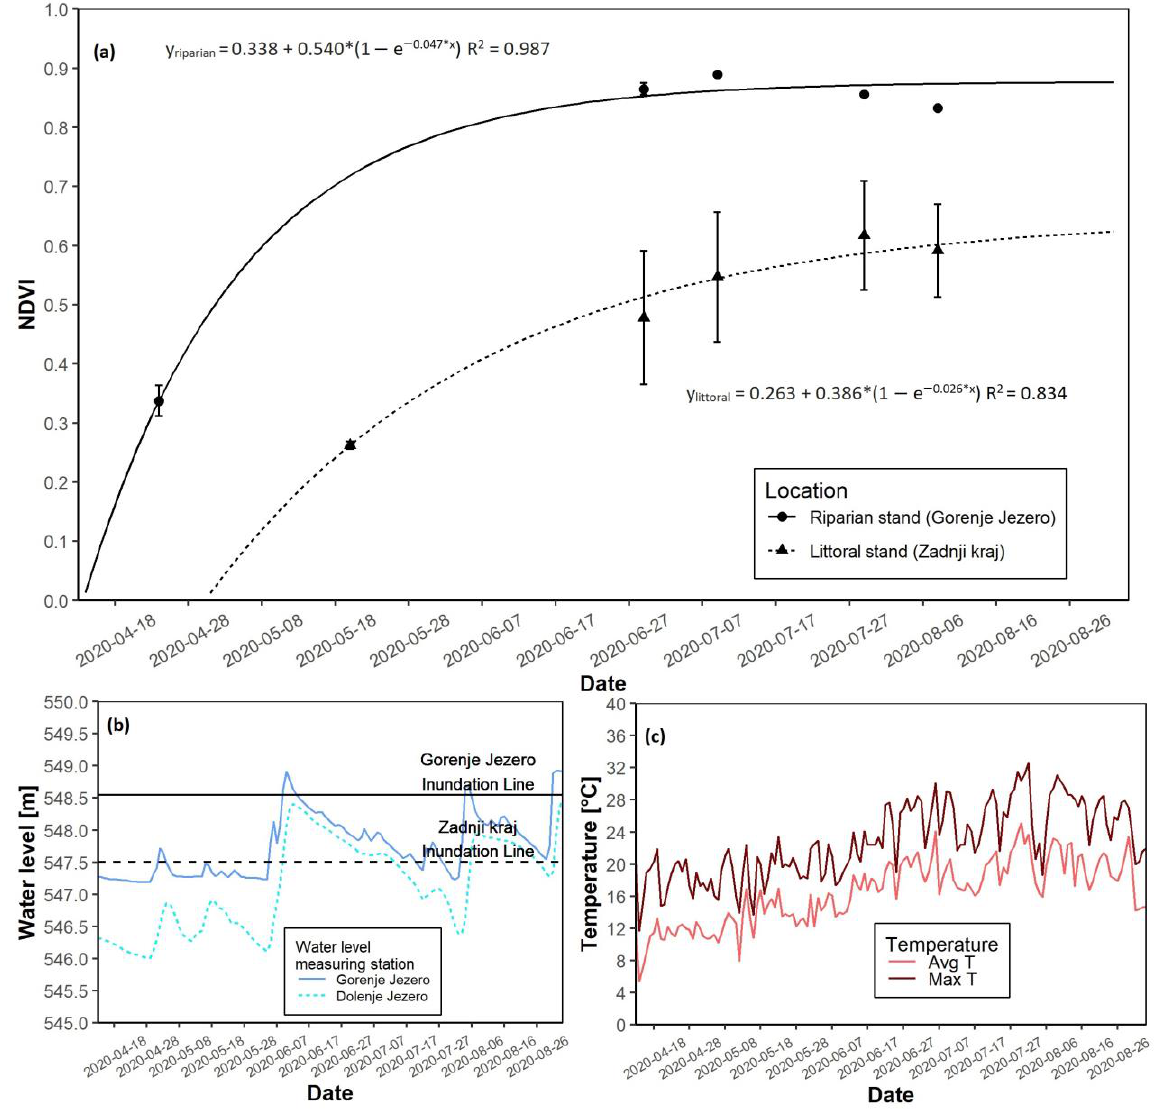
Figure 7. NDVI growth models for both reed sites with water level data for the 2020 growing season. ( a ) NDVI growth models for the riparian and littoral reed stands; ( b ) Water level data for the riparian and littoral reed stands; ( c ) Daily average and maximal temperatures.